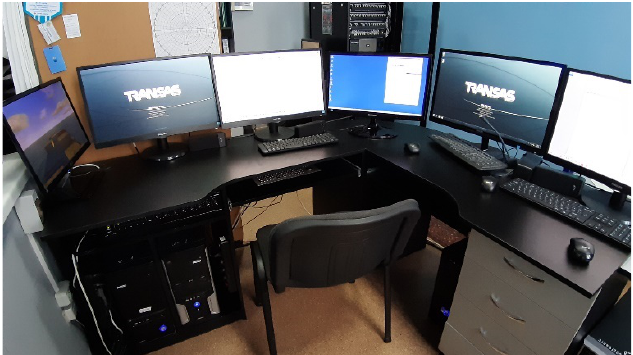
Fig. 1. Instructor’s workplace of NTPro 5000 navigational simulator.